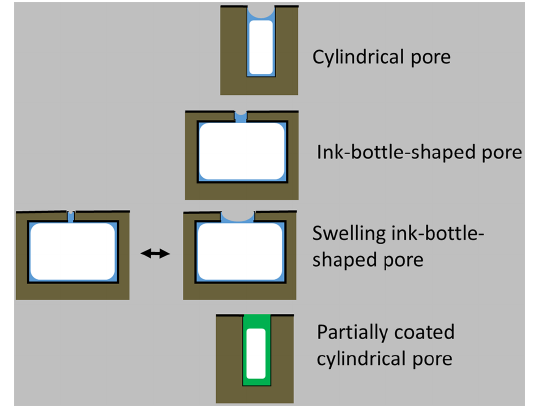
Figure 4. Pore types investigated for their capability to pre-activate. The pores are sketched in pre-activated state with ice inside. Colour code: white – ice; blue – water; green – concentrated solution; brown – pore wall. Note that at the wall and in the opening, a quasi- liquid layer of water or in the case of the coated pore a concentrated solution is